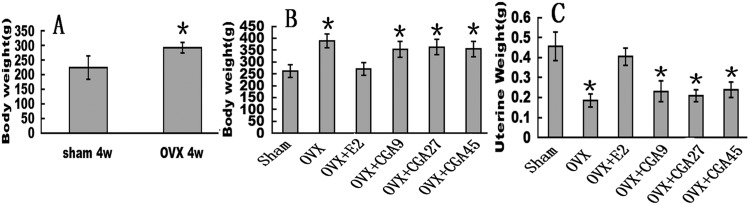
Effects of OVX, E2, and CGA on body and organ weights.OVX rats were treated for a total of 12 wks. Each column represents the mean ± SD of 10 rats. *p < 0.01 vs. sham group. (A) Body weight at week 4 post-OVX or -sham procedure. (B) BW of OVX rats were treated with E2 or CGA for 12 wks. *p < 0.05 vs. sham group. (C) Uterine weight of OVX rats given E2 or CGA. *p < 0.01 vs. sham group.